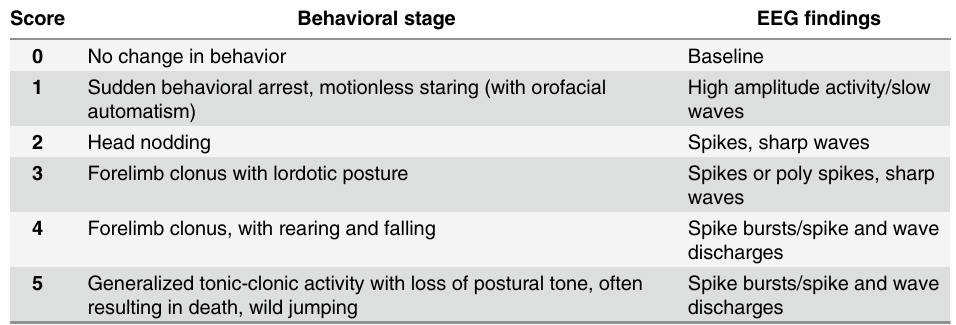
Table 1. Modified Racine ’ s